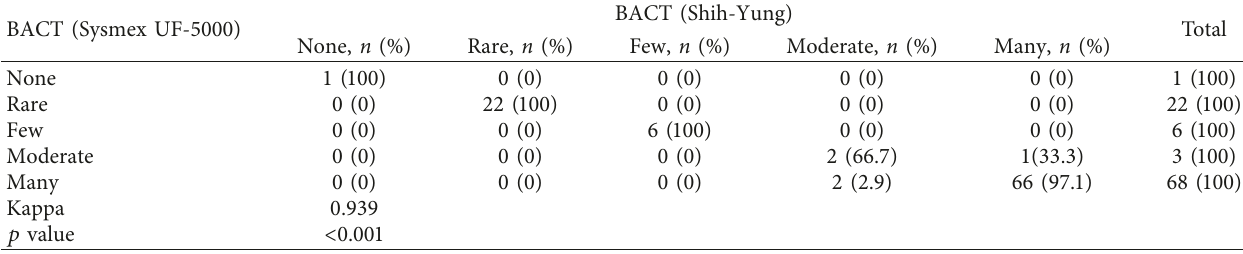
Table 3: Cross-tabulation and a kappa value of Sysmex UF-5000 and Shih-Yung (bacterial parameter).